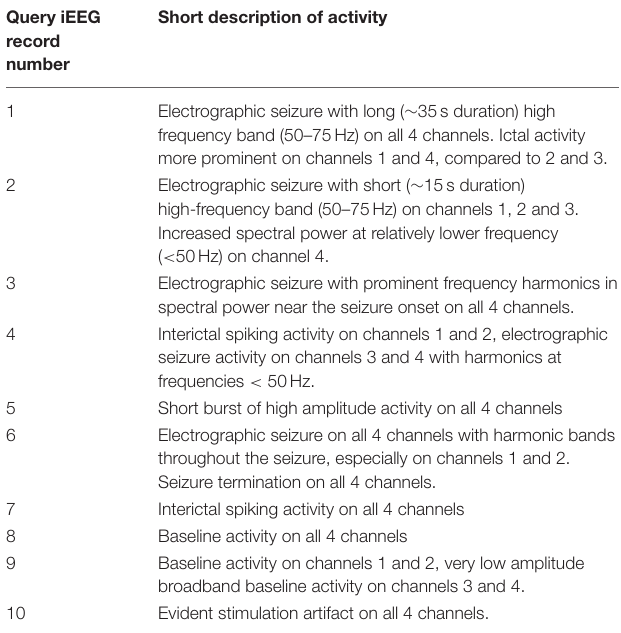
TABLE 2 | Brief descriptions of the 10 test/query iEEG